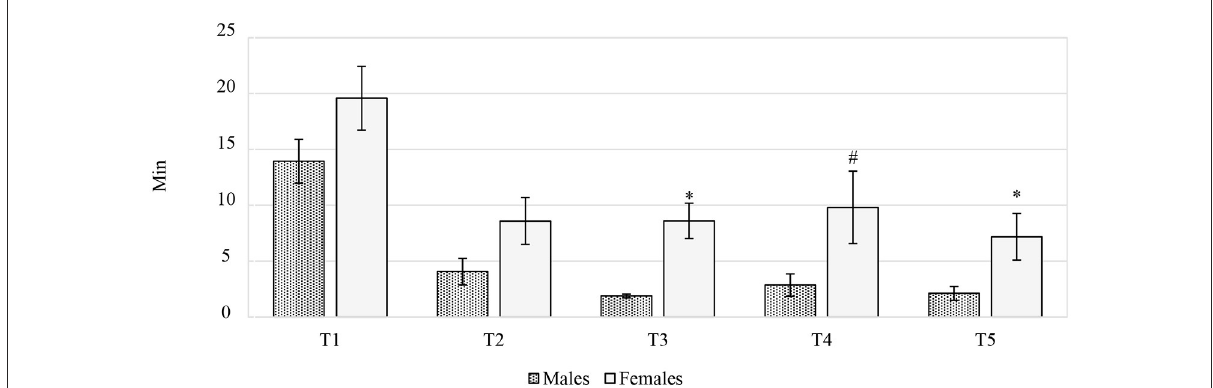
FIGURE3 The time spent by the Label Rouge Naked Neck birds on eating live black soldier fly larvae ( n = 10). * P ≤ 0.05; # P ≤ 0.10. T1, 28–39 days of age; T2, 40–50 days of age; T3, 51–62 days of age; T4, 63–74 days of age; T5, 75–81 days of age.